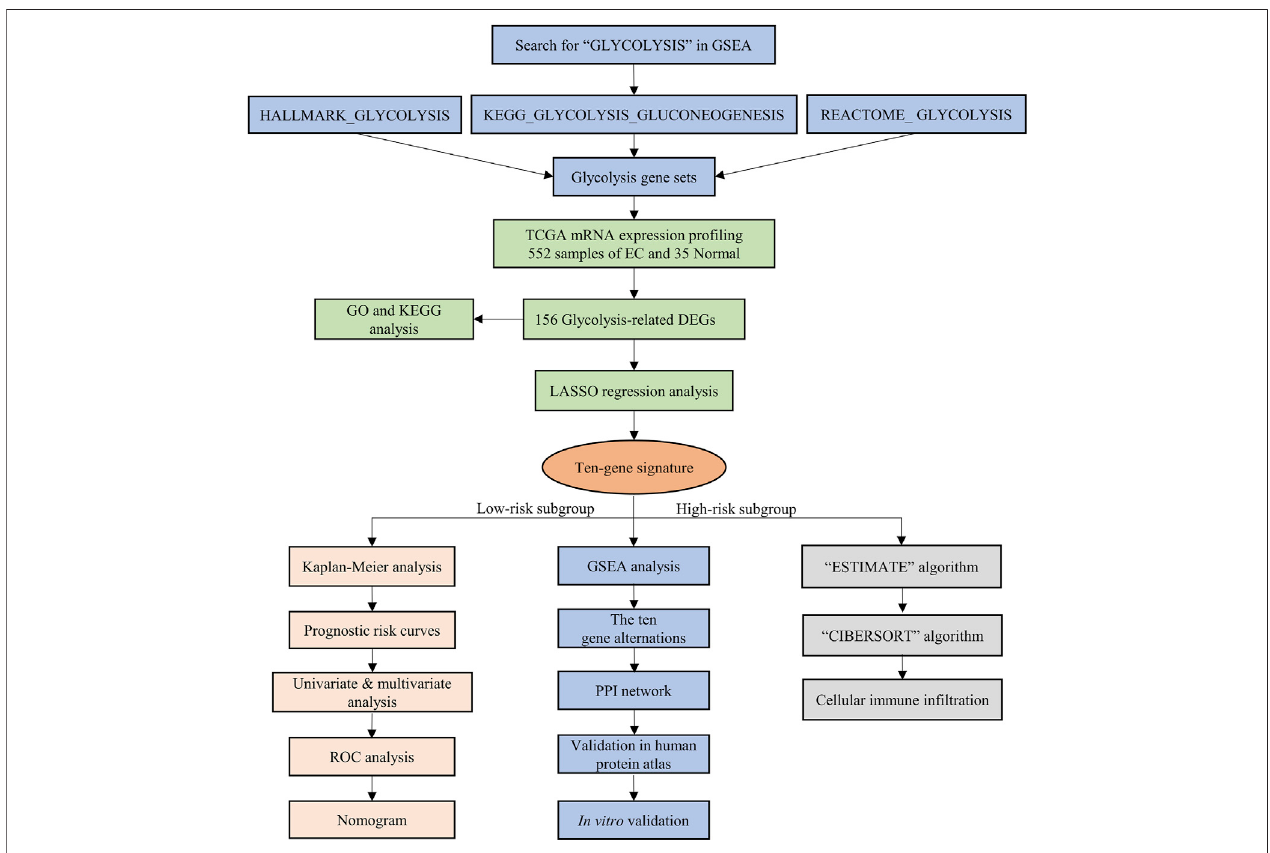
FIGURE 1 | The fl ow chart of the study design and analysis.